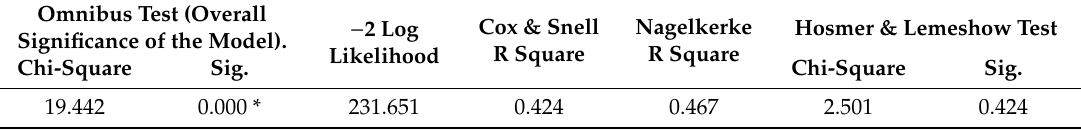
Table A1. Goodness of fit logistic regression model.